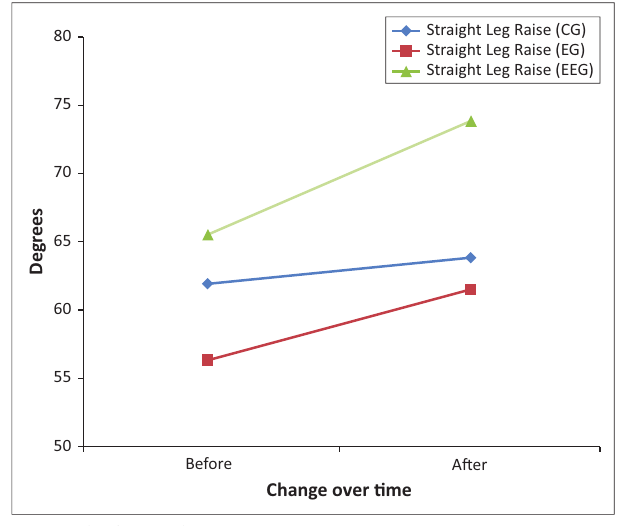
FIGURE 2: Straight leg raise before and after different ultrasound explanations.